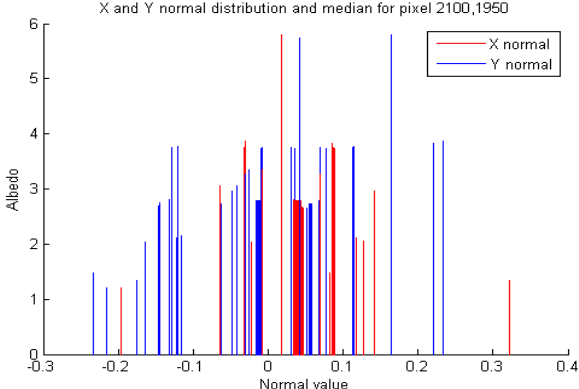
Figure 11. Distribution of values for the X normal (red) and Y normal (blue) for a single pixel in the image.